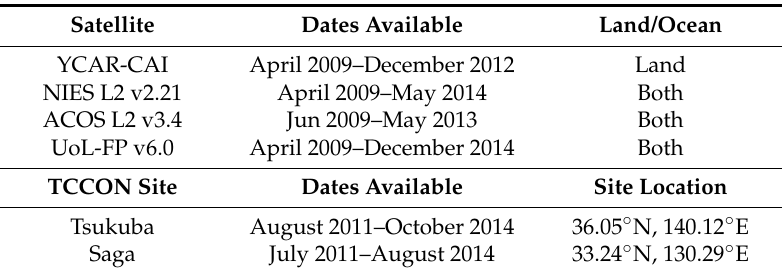
Table 2. Summary of the CO 2 datasets used in this